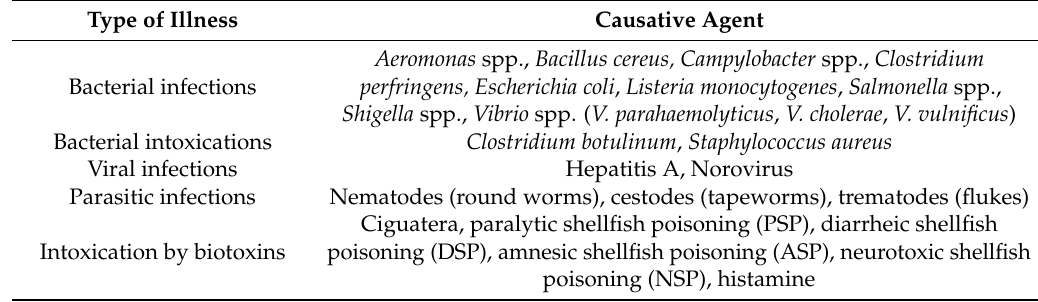
Table 1. Biological hazards associated with seafood (adapted and modified from